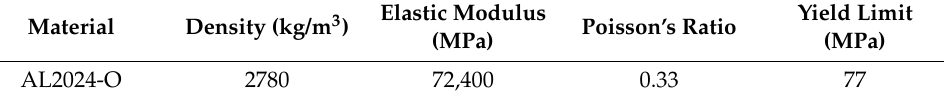
Figure 4. Modelling of rolling in the Abaqus software. Table 1. Mechanical properties of AL2024-O.